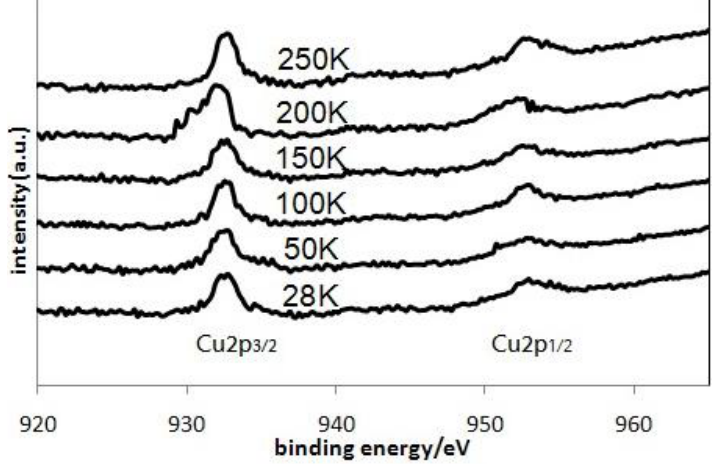
and Cu2p peaks) for Cu-W-RR-ch 1/2 3/2